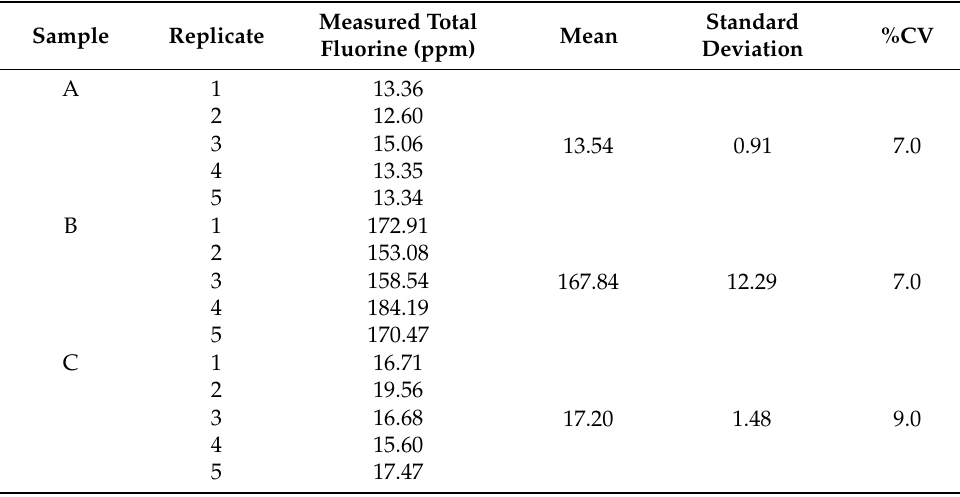
Table 5. Total fluorine measurements for repeatability evaluation.